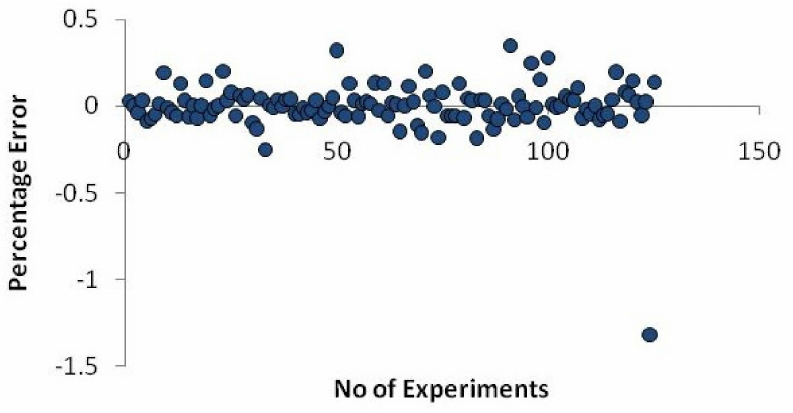
Figure 8. Network 4-2-3 error graph for angular distortion showing time gap between two